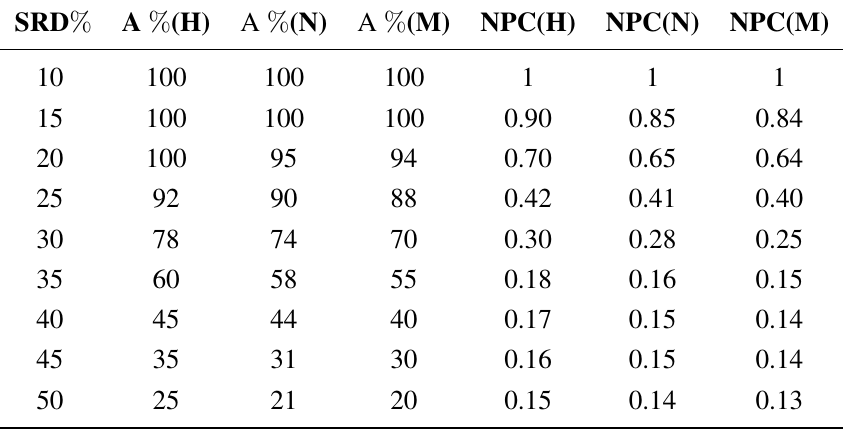
Table 8. Comparison on accuracy and